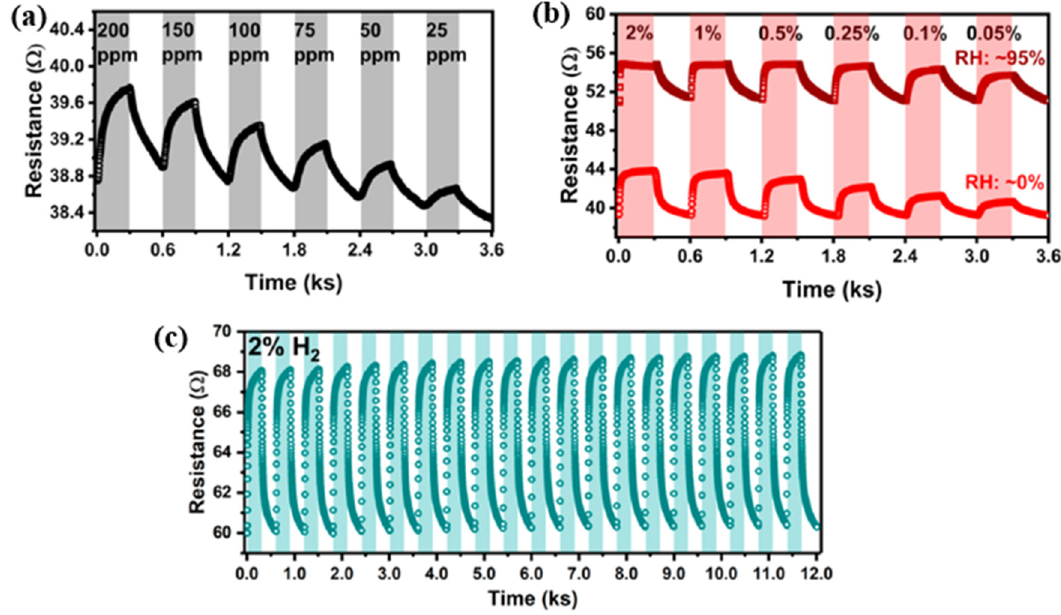
Figure 38. ( a ) Sensitivity of Pd-CGB sensor at ppm levels of H 2 concentration from 25 to 200 ppm. ( b ) Effect of humidity on the sensor performance at two relative humidity (RH) levels: RH~0% and RH~95%. ( c ) Repeatability test of Pd-CGB sensor at 2% H 2 for 20 cycles [170]. Copyright (2020), with permission from American Chemical Society.